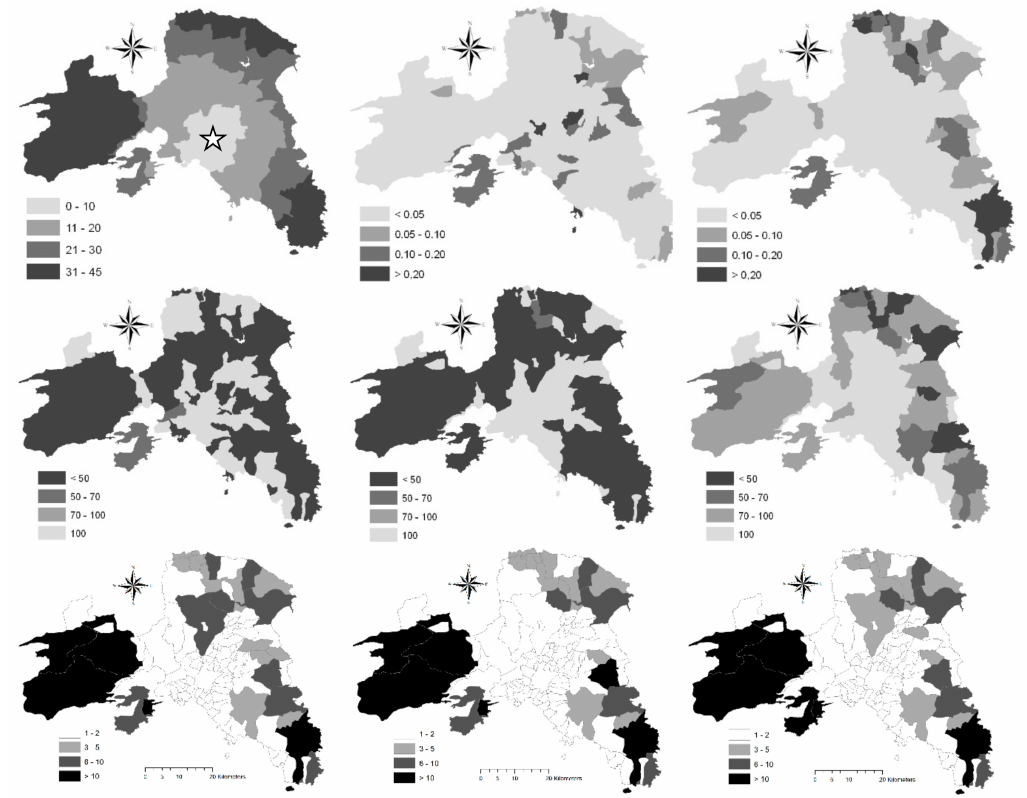
Figure 5. Upper line : ( left ) distance (km) from downtown Athens (star), and density of sparse settlements (per km 2 ) in 1951 ( middle ) and 1991 ( right ); central line : percent share of resident inhabitants in urban centers in 1951 ( left ), 1971 ( middle ) and 1991 ( right ); lower line : number of settlements in the study area at three sequential decades ( left : 1990s; middle : 2000s; right :